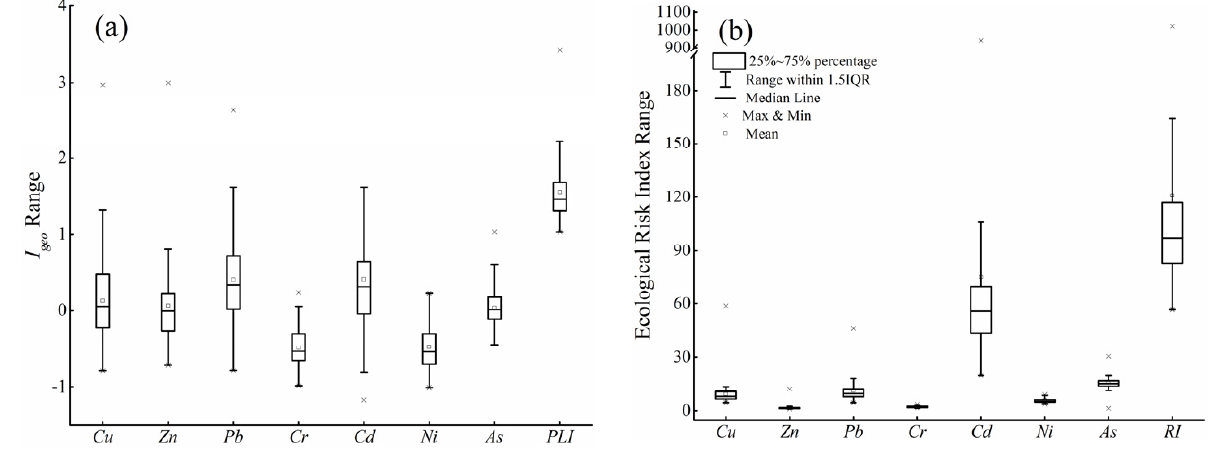
Figure 2. Geo-accumulation index ( I geo , a ) and ecological risk index ( b ) of HMs.